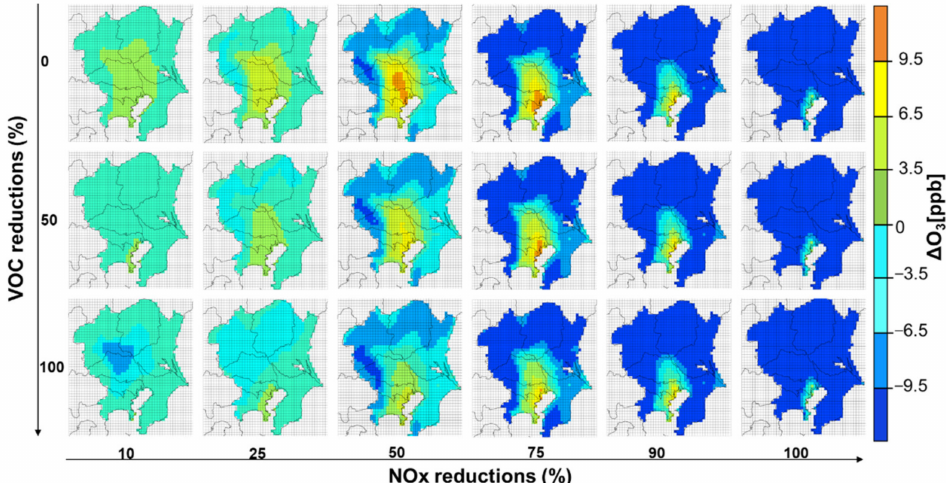
Figure 5. Difference in the ozone concentrations between the base year and simulated scenarios. The maps are arranged according to the reductions in NO x and VOC Levels. The reductions increase top-down for VOC and left-right for NO x